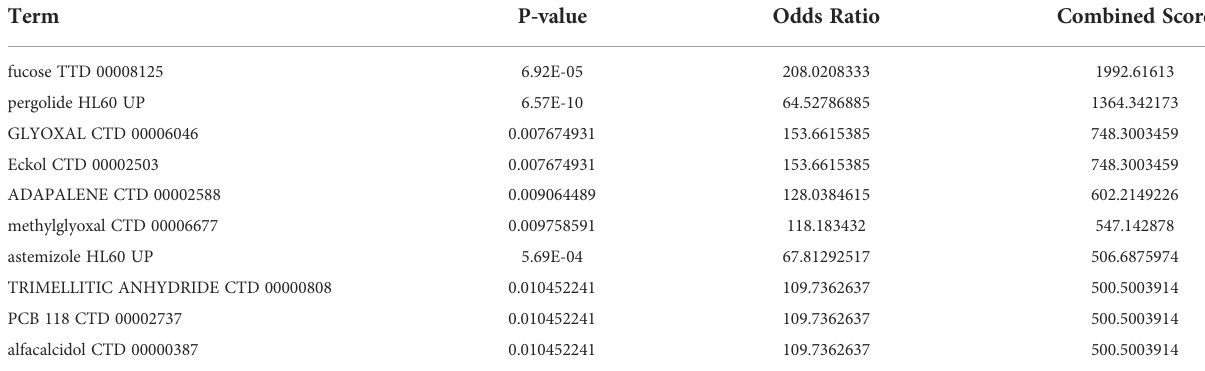
TABLE 3 Suggested top 10 small molecules for